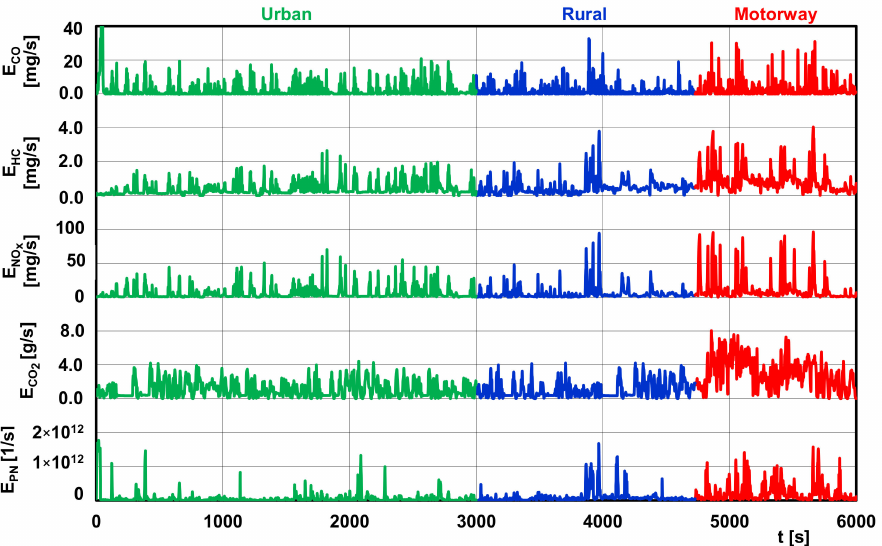
Figure 5. Carbon monoxide, hydrocarbons, nitrogen oxides, carbon dioxide, and particle number emission intensity as a function of time in the RDE